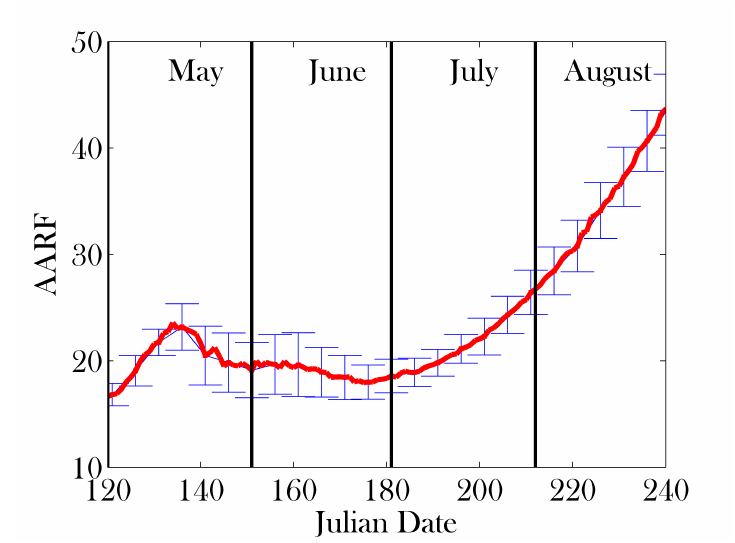
Figure 6. Results of sensitivity analysis on Average Age of Recruitment to Foraging (AARF): mean (red line) ± one standard deviation (error bars). Parameter sets were sampled using Latin hypercube sampling [61] with 10 divisions from the mean values provided in Table 1, ranging ± 20%. The parameters on which sensitivity analysis was performed appear in bold in Table 1.